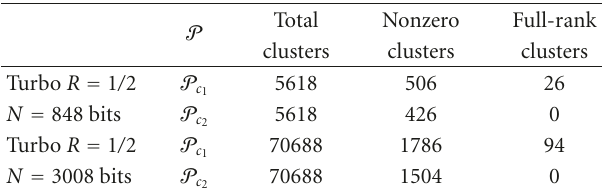
Table 1: Cluster Statistics on the turbo codes from the DVB standard, with a clustering size of P =